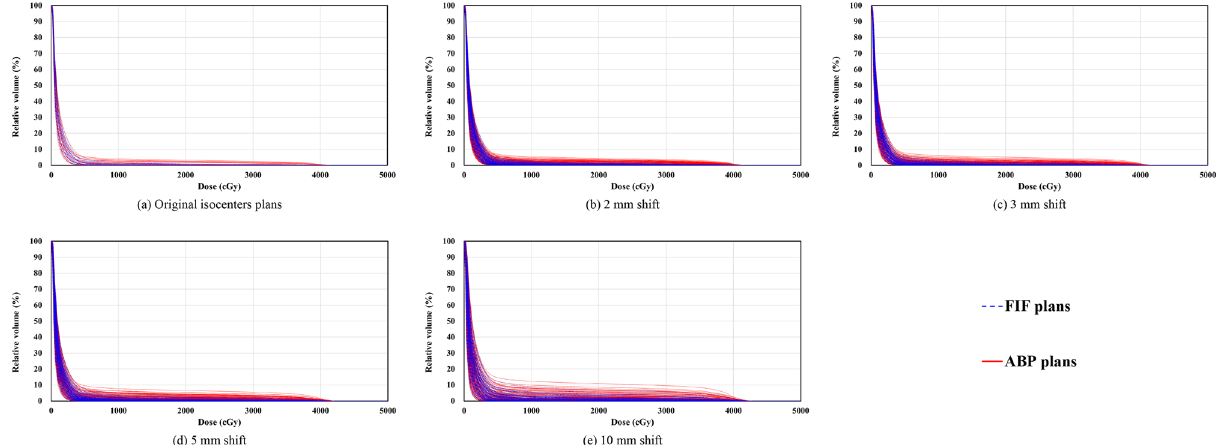
Figure 2. Comparison of dose-volume histograms of the heart among FIF plans and ABP plans. FIF, field-in- field technique; ABP, automated breast